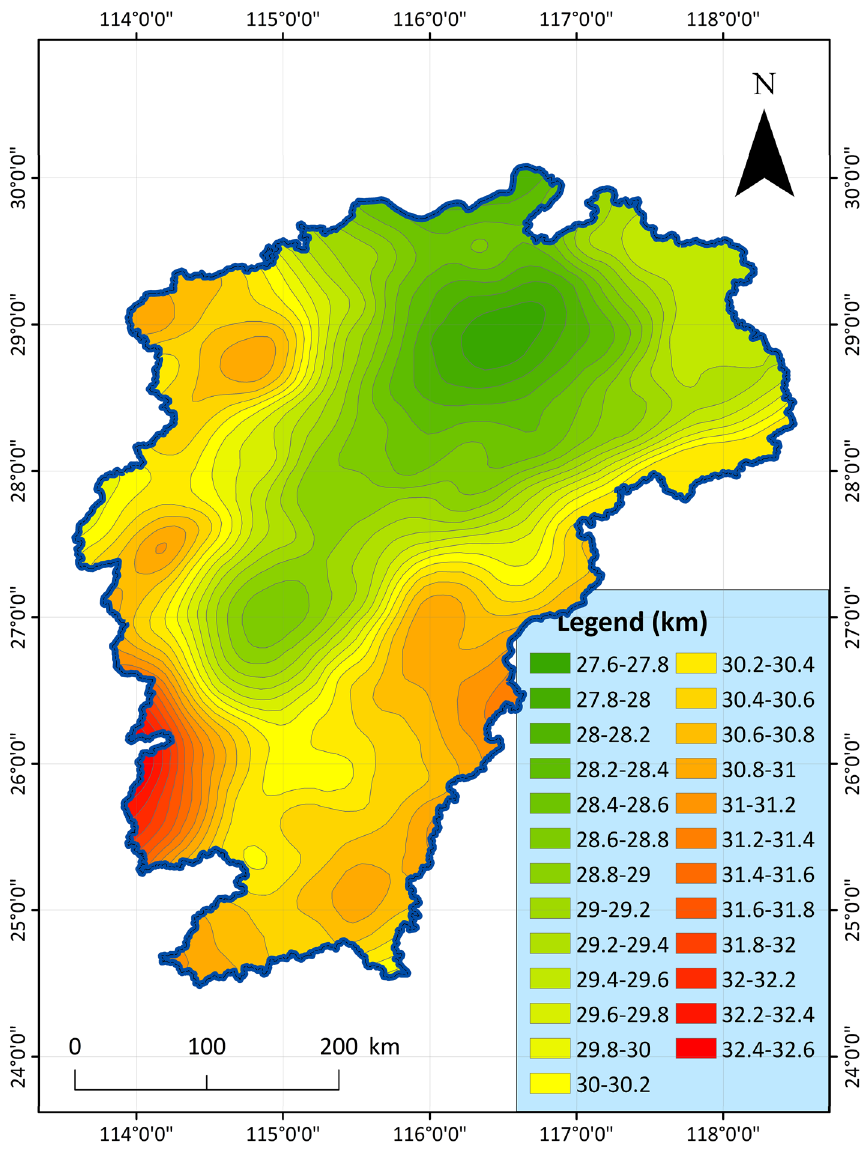
Figure 4. Distribution characteristic map of Moho depth in Jiangxi Province 51